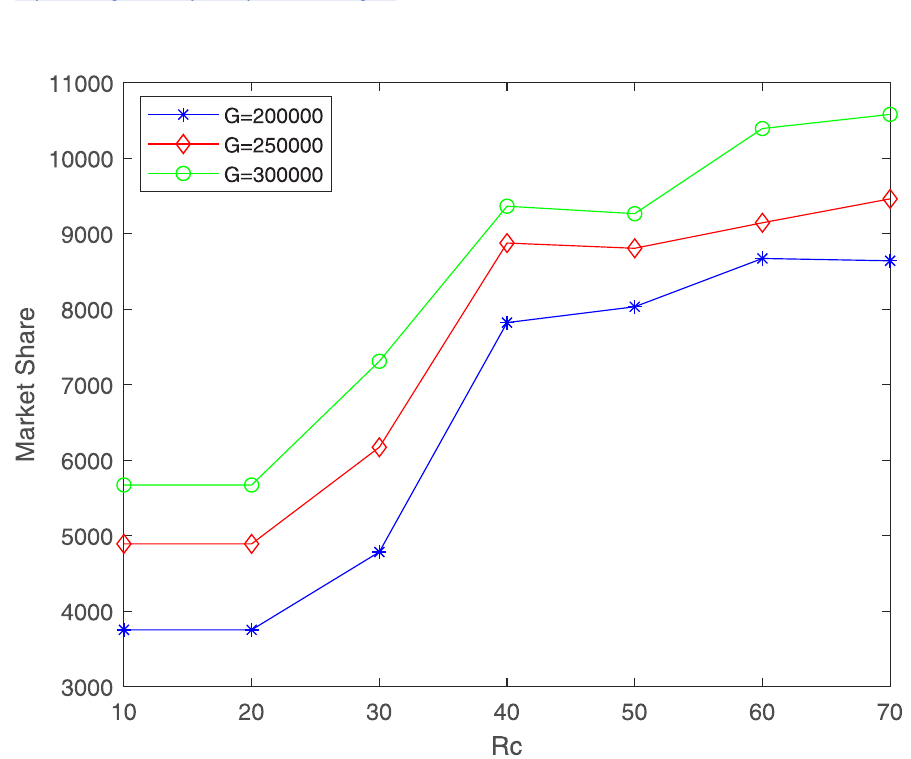
Fig 4. The relationship between market share and R